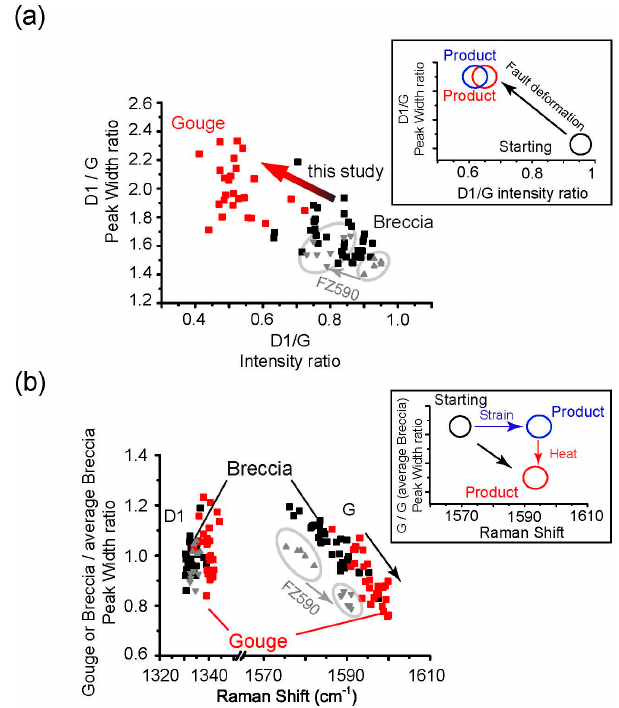
Figure 4. Decomposition of Raman spectra of FZ760 samples. ( a ) D1/G peak width ratio versus D1/G intensity ratio. Grey triangles representing the FZ590 results, and the grey arrows showing the variation of Raman spectra observed from breccia to gouge [21,33]. The inset showing a representative trend of Raman spectrum derived from the starting materials and deformed gouge [21]. ( b ) G peak width of gouge over average breccia peak width versus G band peak position. The inset showing a representative trend of Raman spectrum attributing to strain and high temperature pulses derived from the starting materials and deformed gouge [21].